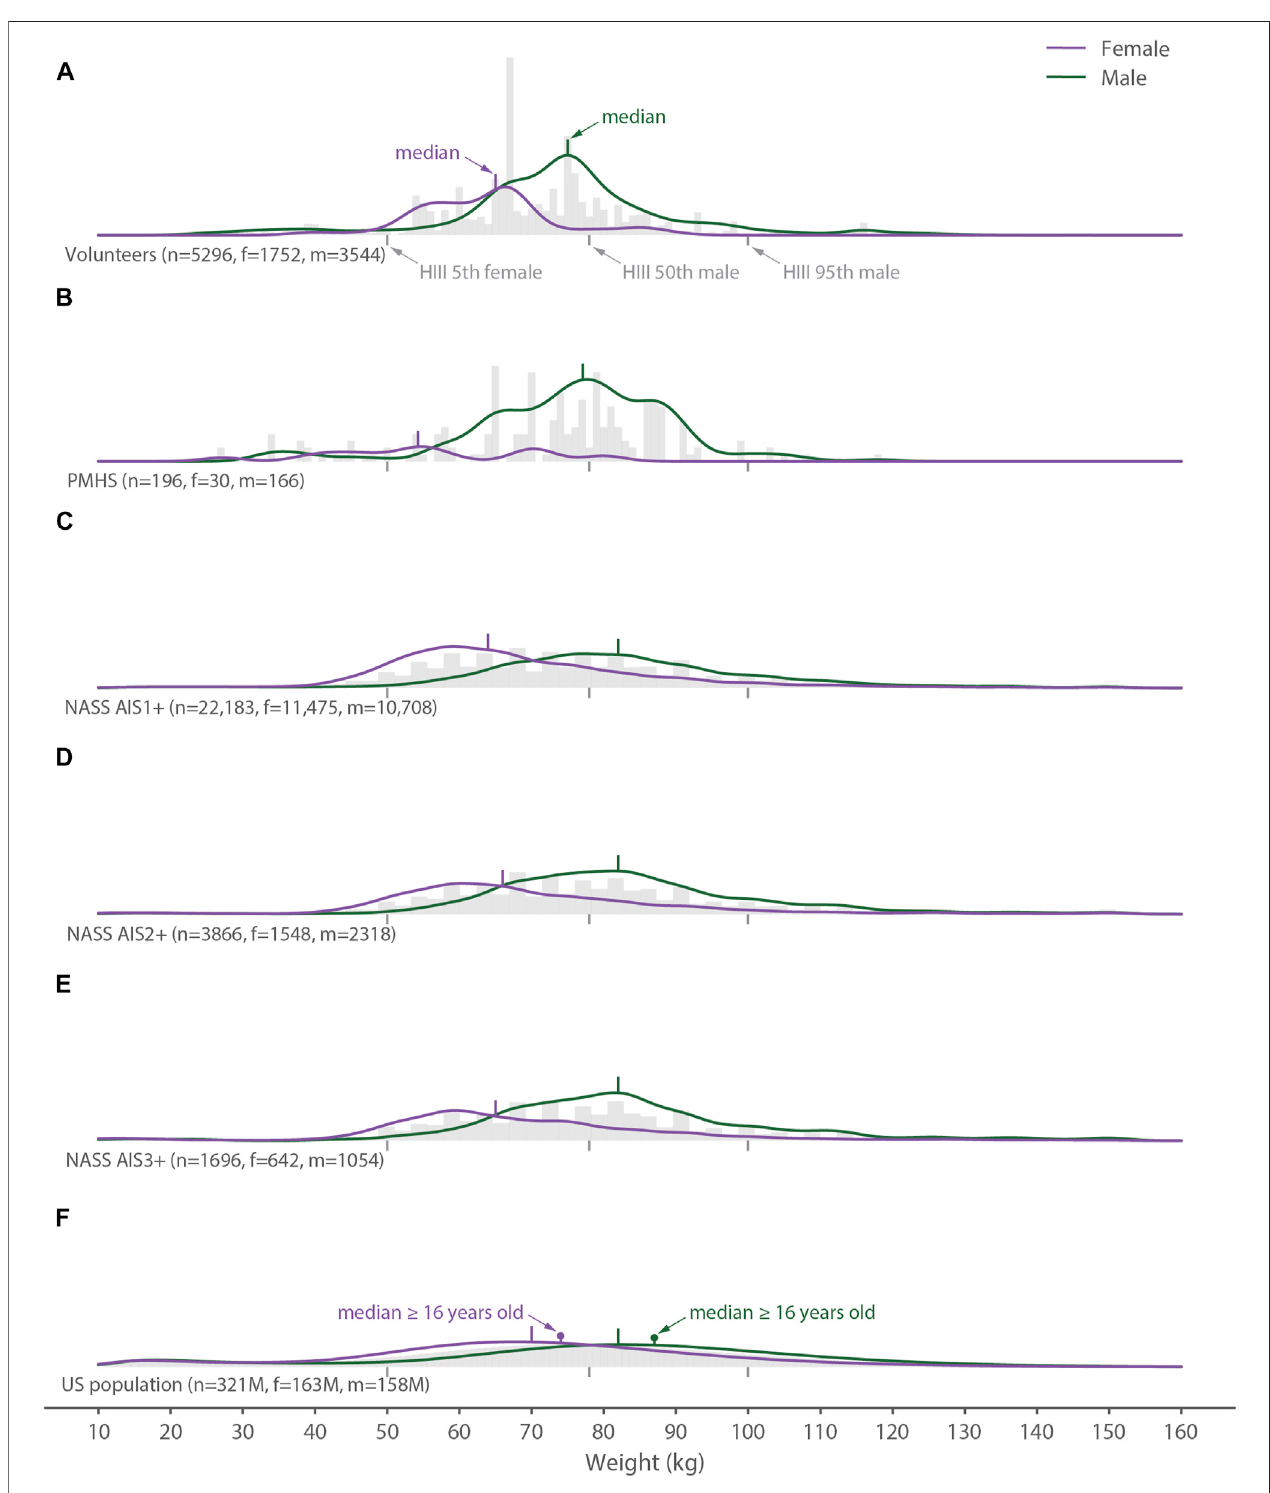
FIGURE 4 | Distribution of all weight data (gray histograms), females (purple lines) and males (green lines) for (A) the volunteer tests, (B) the PMHS tests, (C) the NASS AIS1+ data, (D) the NASS AIS2+ data, (E) the NASS AIS3+ data, and (F) the United States population. The gray vertical bars below each histogram show the weights of the 5th percentile female, 50th percentile male, and 95th percentile male Hybrid III crash test dummies.